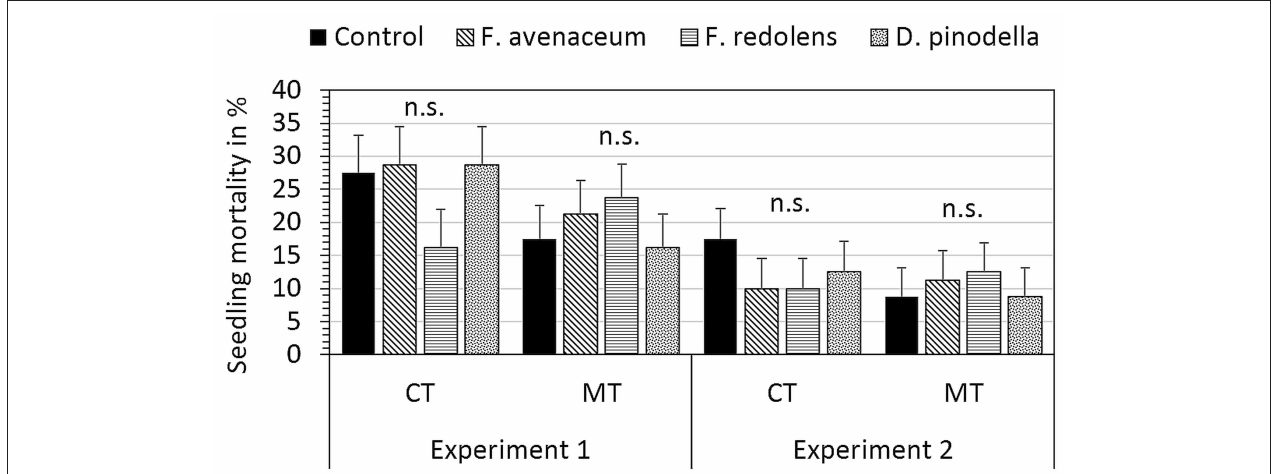
FIGURE 1 | Seedling mortality and standard errors for each inoculation treatment ( F. avenaceum, Fusarium avenaceum; F. redolens, Fusarium redolens, D. pinodella, Didymella pinodella , Control, non-inoculated natural soil) within each field experiment and tillage treatment (CT = plough tillage without organic mulch; MT = minimum tillage with organic mulch application to potatoes). Standard errors derived from linear mixed effects models and estimated marginal means.